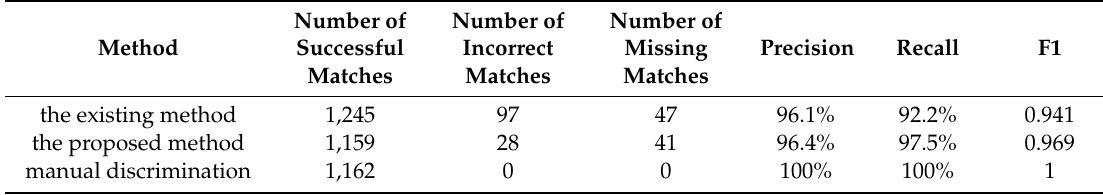
Table 1. Overall Point of Interest (POI) matching